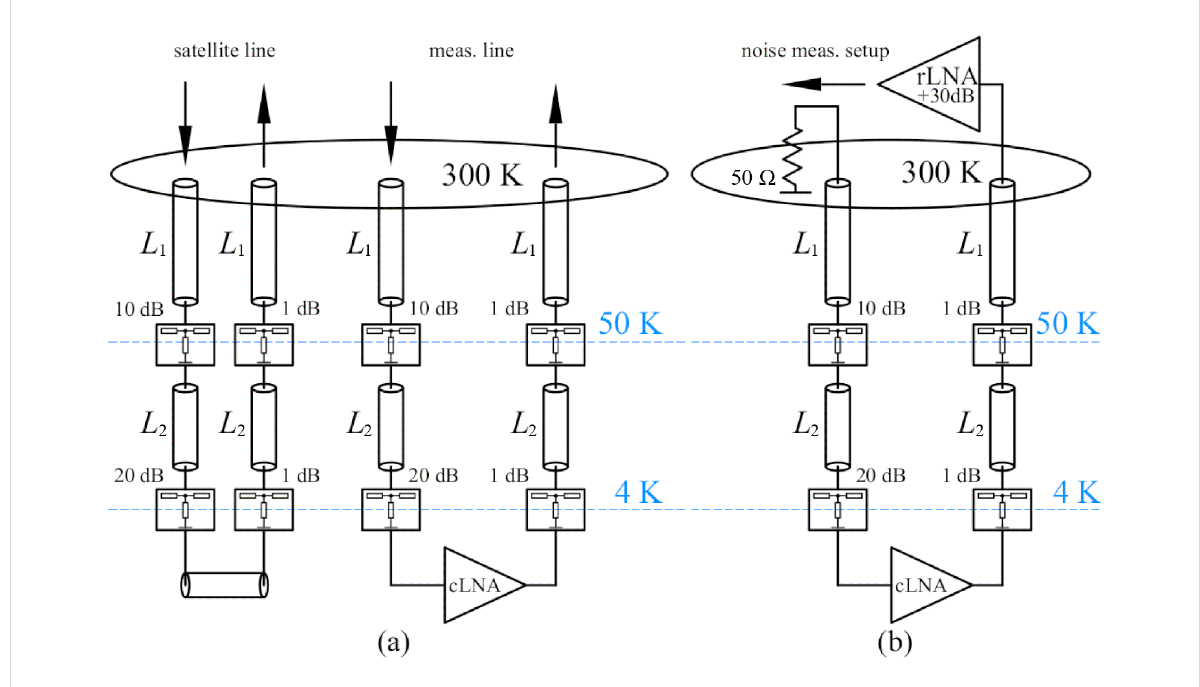
Figure 3: Noise and gain measurement setup. (a) Calibration lines (left-hand side sketch) and gain measurement setup (right-hand side sketch). (b) Noise measurement setup for the cryogenic LNA.